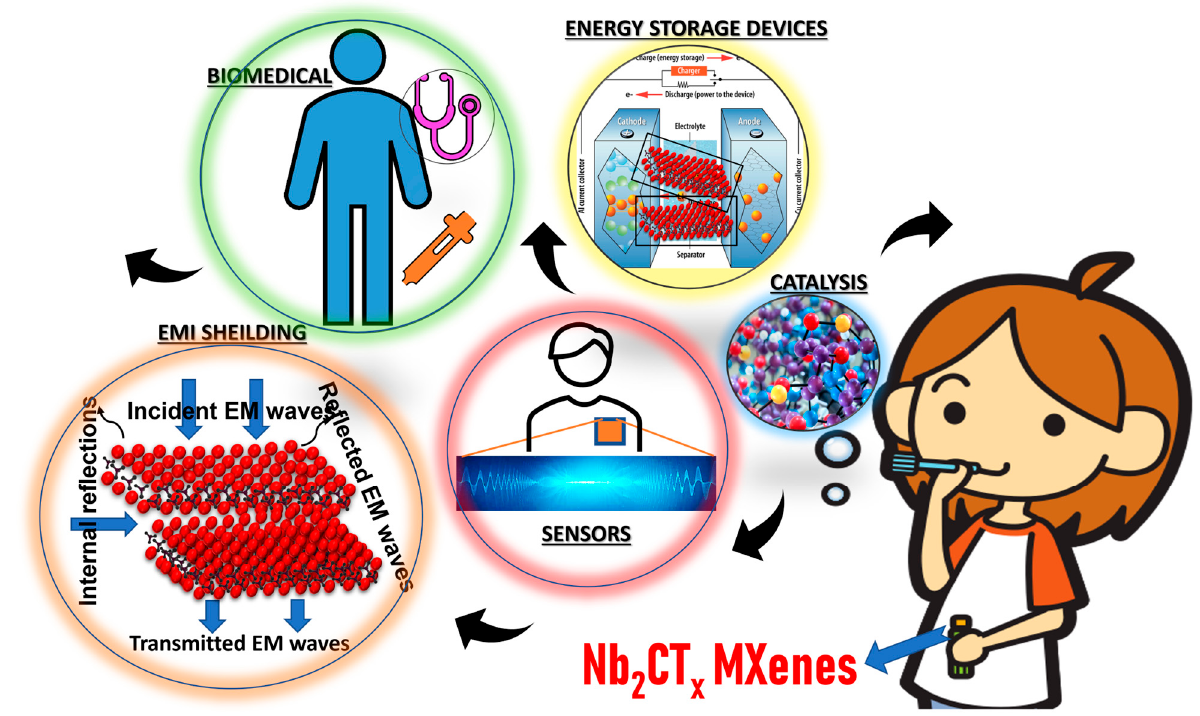
Figure 1. The overview of 2D Nb 2 CT x MXene and their applications, presented through blowing bubbles art.